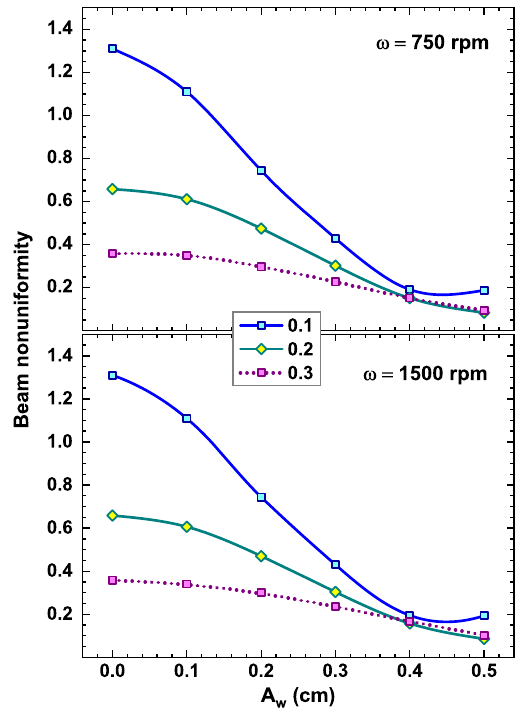
FIG. 16. The same as in Fig. 15, but for the beam nonun- iformities resulting from the MC simulations for the square diaphragm of 1 × 1 cm. See details in the